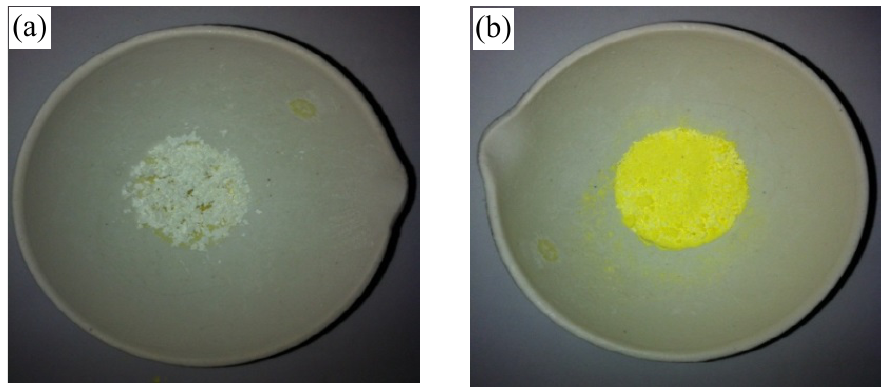
Figure 1: The resulting products synthesized using H 2 C 2 O 4 as precipitating agent (a) after drying, and (b) after calcination.